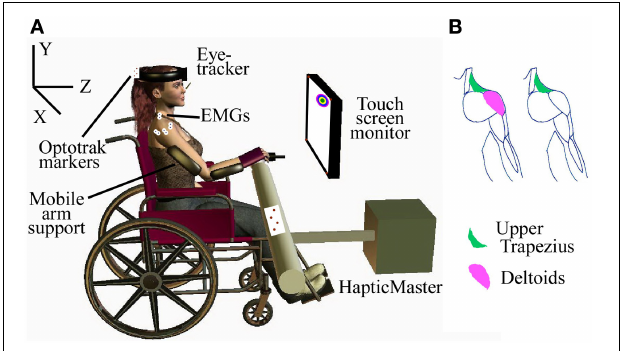
FIGURE 1 | Experimental setup. (A) Subject with SCI performing assisted-reaching task with multimodal decoder; (B) EMGs recorded in the subjects, based on the muscles that could be voluntarily